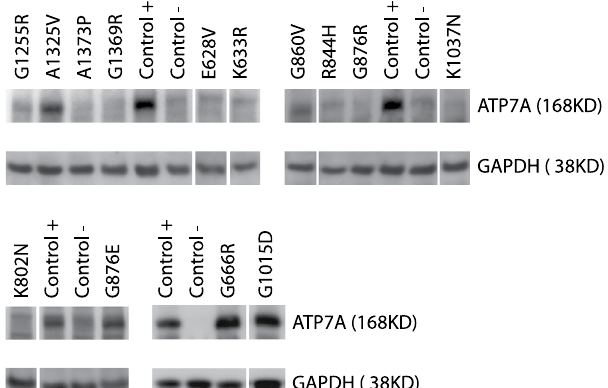
Figure 4. Western blots of lysates from MD fibroblasts. Western blots of lysates from MD fibroblasts with no detectable ATP7A protein when analysed by Immunofluorescence (IF). The specific ATP7A missense mutations are indicated above the lanes. Control + lysate from normal fibroblasts. Control − lysate from MD fibroblasts containing a big deletion of the ATP7A gene (exon 3–23 deleted). The protein product of the housekeeping gene GAPDH was used as an internal control for correct loading of 25 μ g protein in each lane. The staining of ATP7A and GAPDH was performed on one membrane cut in two. Gaps indicate separate gels. Small gaps indicate that the gel was cut in producing the